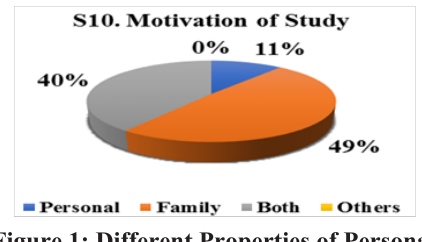
Figure 1: Different Properties of Personal Information (source: Primary data)